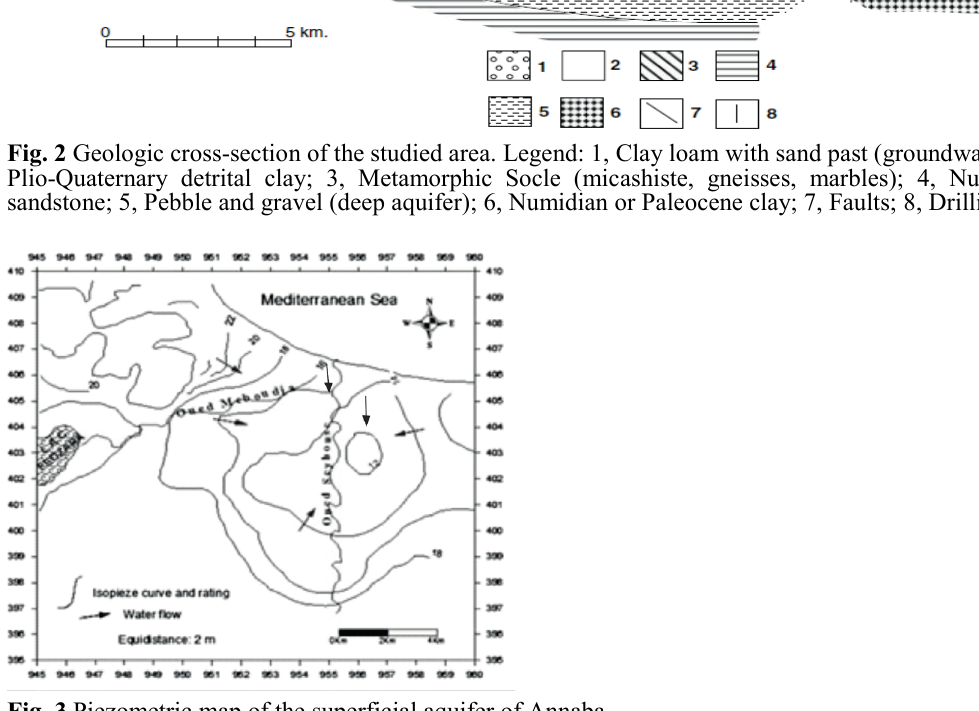
Fig. 3 Piezometric map of the superficial aquifer of